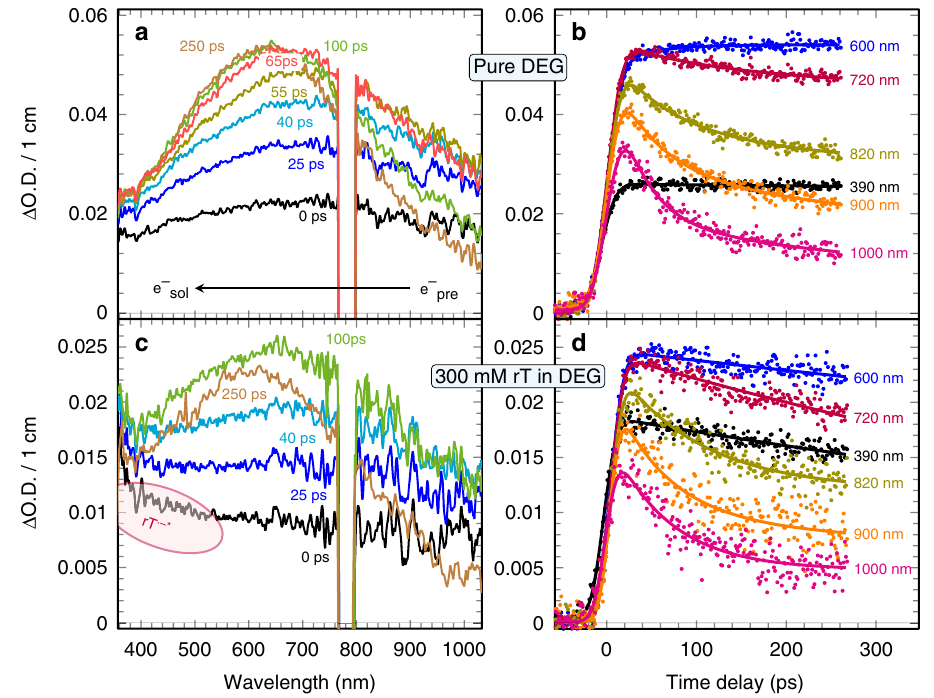
Fig. 2 Transient absorption pro fi les of pure diethylene glycol and ribothymidine solutions under ambient conditions. Spectra ( a , c ) and kinetics ( b , d ) for neat DEG and 0.3 M ribothymidine (rT) solutions, respectively. The region at 780 nm is fi ltered out. The duration of the electron pulse is ~7 ps. The dose per electron pulse is 25.3